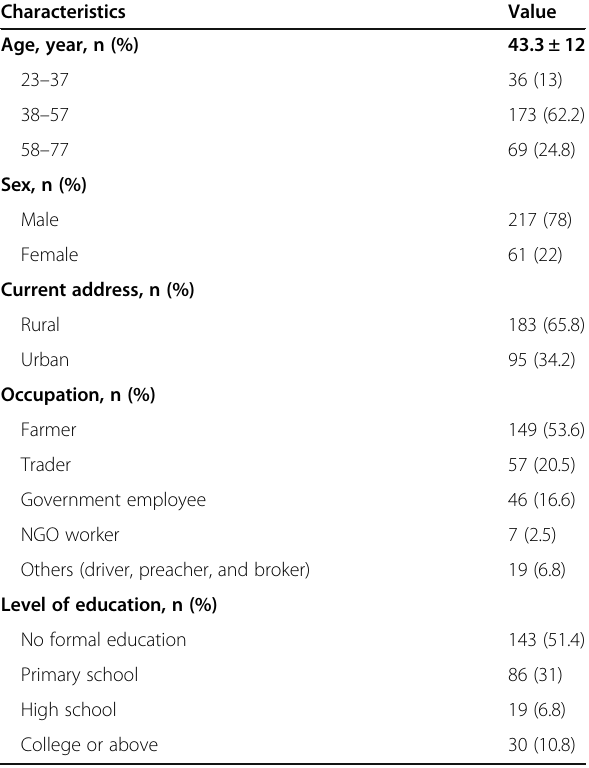
Table 1 Sociodemographic characteristics of the respondents